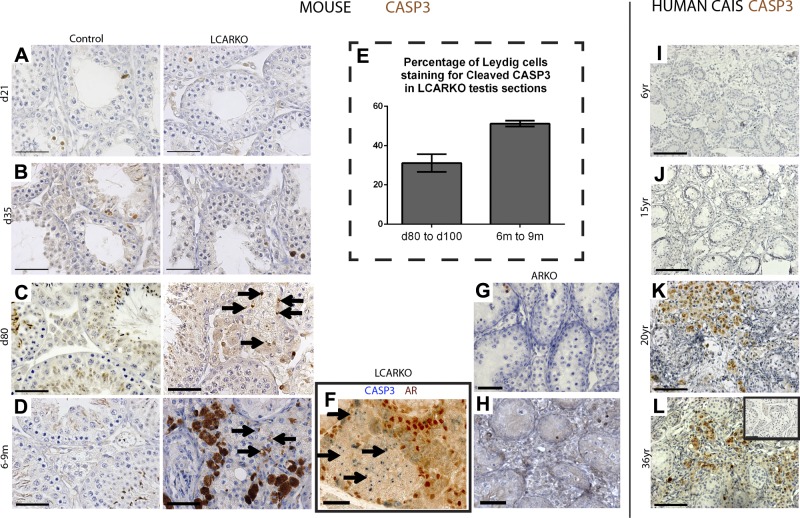
Apoptosis is seen in both aged LCARKOs and CAIS patient biopsies. A and B) No interstitial apoptosis (marked by CASP3 immunostaining) was observed in the interstitium of d 21, or d 35 control or LCARKO testes. A few germ cells were noted to stain for CASP3 in each section. C) No interstitial CASP3 immunostaining was observed in the interstitium of d 80 control mice. Punctate CASP3 immunostaining was observed in cells with Leydig cell morphology in d 80 LCARKO mice (arrows). D) Extensive interstitial apoptosis was noted in the interstitium of 6- to 9-mo-old LCARKO testes, unlike age-matched controls. E) When quantified, 31% of Leydig cells at d 80–100 and 51% of cells at 6–9 mo were found to immunostain positive for CASP3. F) CASP staining (blue) was noted in AR (brown)-negative cells (arrows), and not AR-positive cells.. G and H) No interstitial apoptosis was noted in either d 80 or aged ARKO mice. I and J) No apoptosis was noted in biopsies from 6- or 15-yr-old patients with CAIS. K and L) Extensive interstitial apoptosis was noted in biopsies from 20- and 36-yr-old patients with CAIS, whereas biopsies from normal adult men (inset) did not show apoptosis. Scale bars, 50 µm.